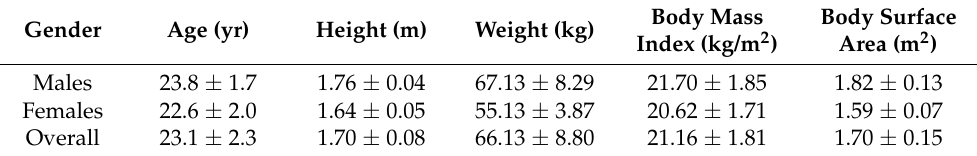
Table 1. Physical characteristics of